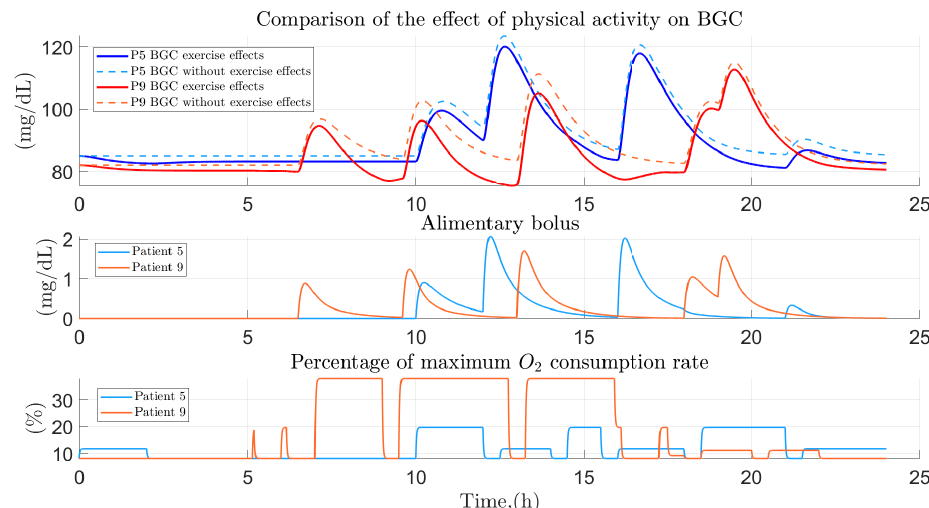
Figure 11. Comparison between the glucose dynamics of a physically active person and one with sedentary tendencies. Contrast between the effect of exercise on glucose lowering between a physi- cally active person and a person tending to be